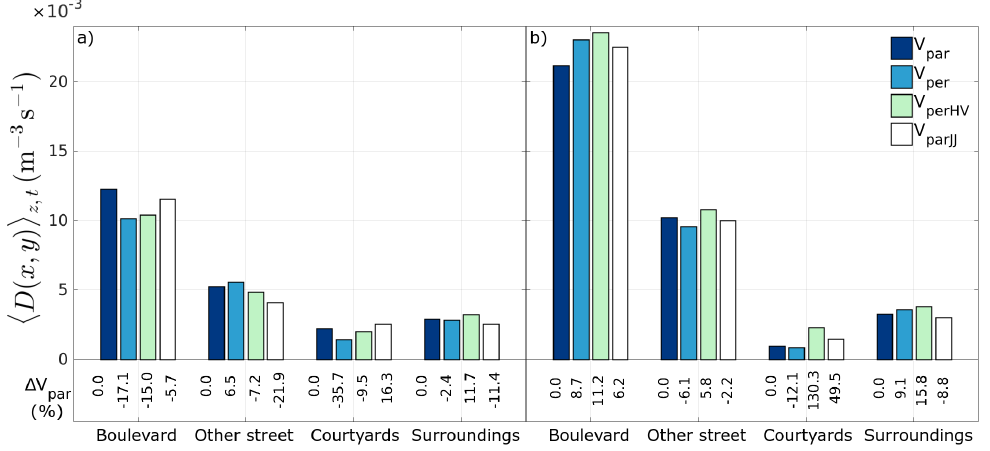
Figure 13. Mean (cid:104) D ( x , y ) (cid:105) t , z ( × 10 − 3 m − 3 s − 1 ) under the ( a ) general and ( b ) wintry inflow conditions separately for the boulevard, other street canyons, courtyards and surroundings between z = 1–20 m for all runs. D is calculated using data from the first 50 s after the particle source has been switched off. The difference to the value in V par is given in percentages ( ∆ V par ).